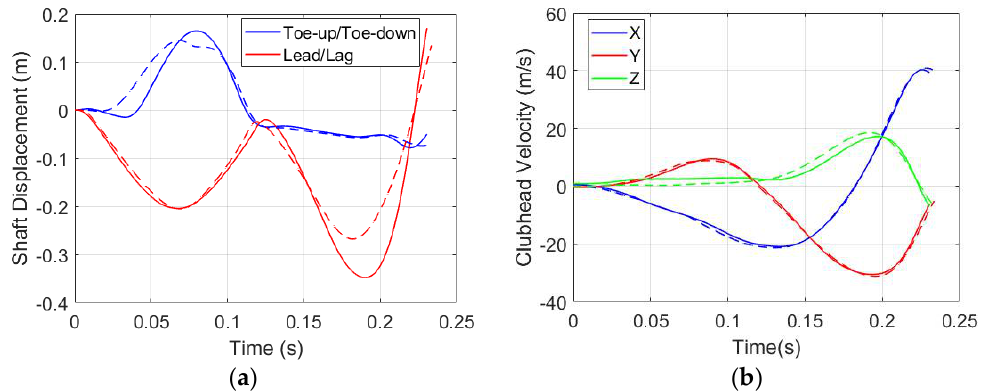
Figure 5. ( a ) Displacement of the clubhead relative to the grip of the shaft in the swing plane; ( b ) Clubhead velocity in each inertial